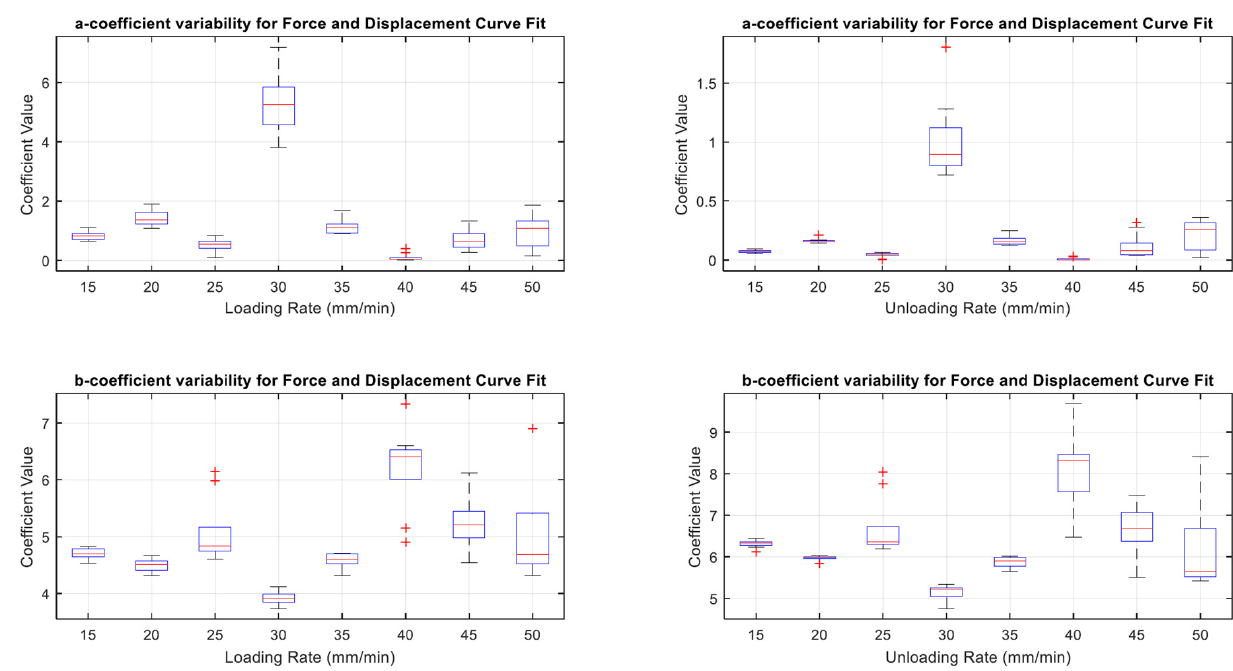
Figure 19. Box Plots showing coefficient variability for Equation (1).